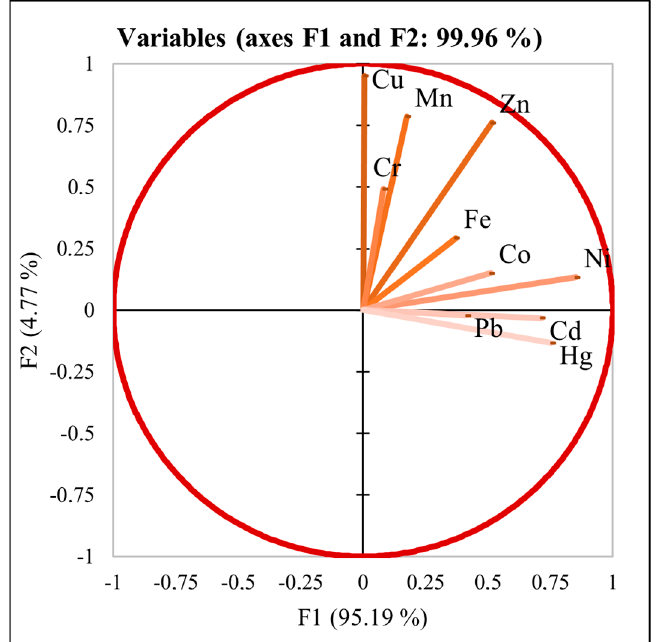
Figure 4. Representation of variables related to geographical origin based on heavy metal content.